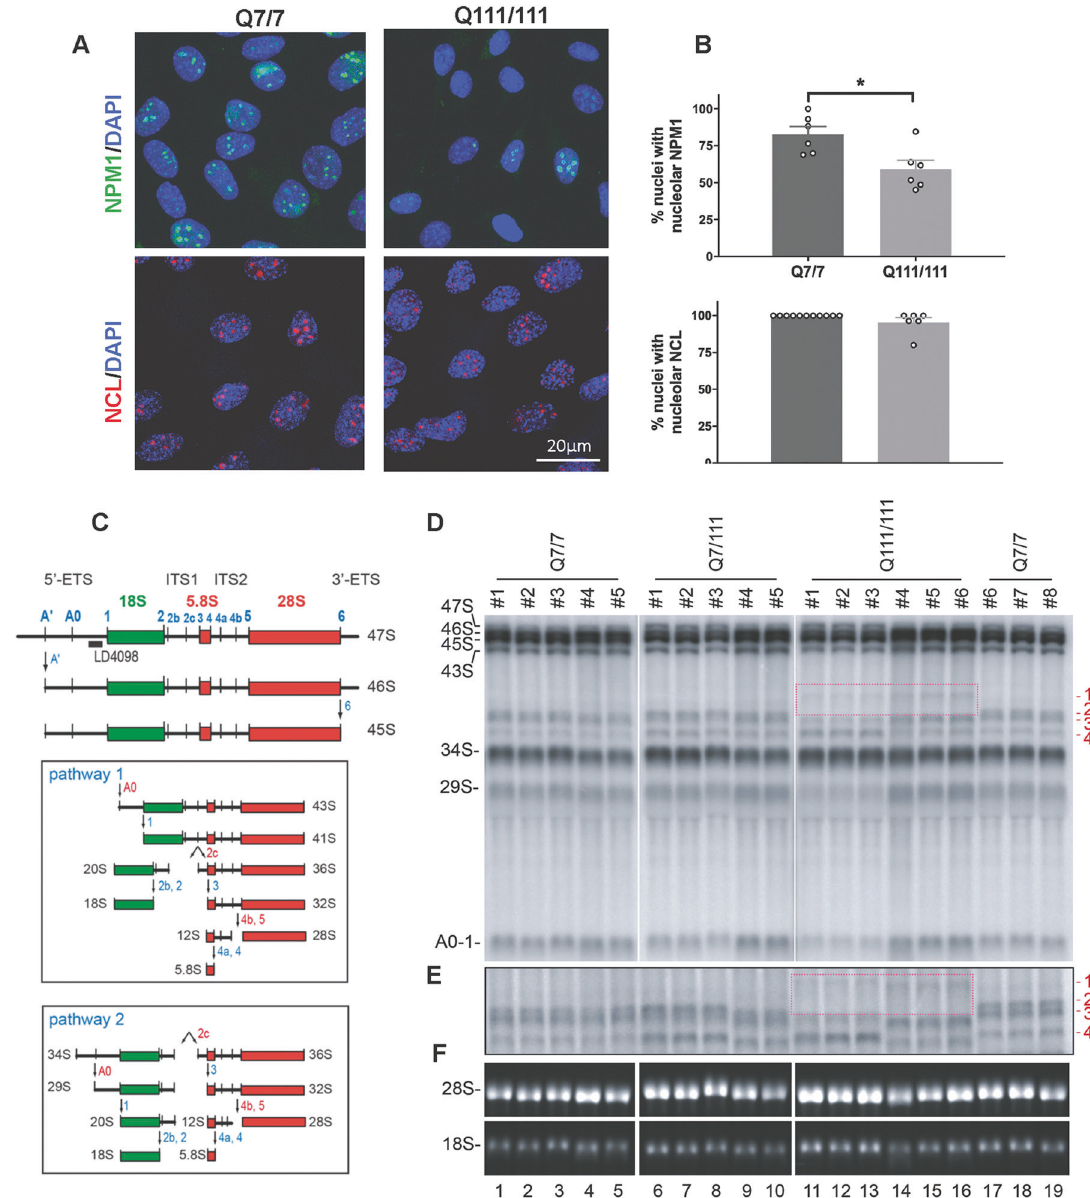
Fig. 1 Cells expressing Huntingtin mutations display altered distribution of nucleolar NPM1 and alterations of pre-rRNA processing. A Representative confocal images of NPM1 and NCL immuno fl uorescence staining in Q7/7 and Q111/111 cells. B Quanti fi cation of the percentage of nuclei with nucleolar ring-like NCL and NPM1 signals. The percentage of nuclei with nucleolar NPM1 is signi fi cantly reduced in the Q111/111 cells by Mann – Whitney U test ( p = 0.014) (n: number of nuclei = 421 in Q7/7 and 634 in Q111/111; N: fi elds of view in two independent experiments = 6 for Q7/7 and Q111/111). Values represent mean values and error bars are SEM. * p < 0.05. Detailed statistical information is included in the Supplementary Statistical Information fi le. C Mouse pre-rRNA processing pathway. Three out of four mature rRNAs (the 18 S, 5.8S, and 28 S) are encoded in a single polycistronic transcript synthesized by RNA polymerase I, the 47S. Mature rRNAs are embedded in 5 ′ and 3 ′ external transcribe spacers (5 ′ - and 3 ′ -ETS) and internal transcribed spacers 1 and 2 (ITS1 and 2) and are produced by extensive processing of the 47S. Processing sites (A ′ , A0, 1 etc.) are indicated in blue. There are two alternative processing pathways in mouse (pathways 1 and 2, boxed) according to initial processing in 5 ′ -ETS or ITS1, respectively. D Total RNA was extracted, separated on denaturing high-resolution agarose gel, stained with ethidium bromide to reveal large mature rRNAs, or processed for Northern blotting. Species labeled “ 1 – 4 ” (in red) are extended forms of the 34S pre-rRNAs that were not previously described. Species “ 2, 3, and 4 ” are detected in the control cells (Q7/7). Species “ 1 ” is only detected in the mutant cells (Q111/Q111). Species “ 1 ” is formed at the cost of species “ 2 ” (the upper band of the doublet). The boxed area highlights the appearance of species “ 1 ” in Q111/Q111 cells, which is concomitant with the disappearance of species “ 2 ” . E The samples described in panel ( D ) were run in a longer migration to separate more ef fi ciently the doublet corresponding to bands “ 2 and 3 ” . F Ethidium bromide staining revealing that the steady state levels of 18 S and 28 S rRNA are not grossly affected. nucleoplasm and in the inclusions con fi rmed the more advanced advanced disease stage, both dopamine 2-receptor (D2r) and D1- neuropathological stage at 10 months (Fig. 3B – F) and [51]. The receptor ( D1r ) mRNAs were decreased at 10 months analysis of human BA4 cortex RNAseq data (GSE79666) [52] and (Fig. 3A) [40]. The percentage of nuclei showing mHTT inclusions, data from the striata and gastrocnemius of zQ175 mice at different area of the mHTT inclusions, and relative mHTT intensity in the Cell Death and Disease (2021)